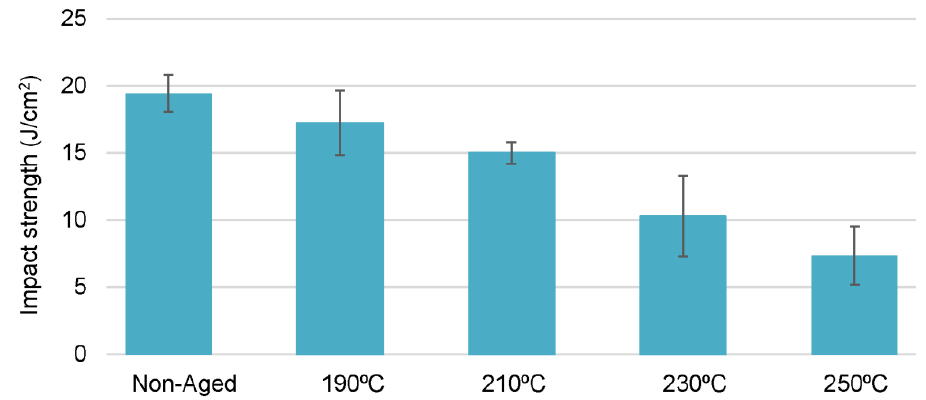
Figure 9. Average impact strength ( E c ) of quasi-isotropic [0/90/ ± 45] 2s laminates aged at different temperatures for 3 days ( E impact = 32.46 J).